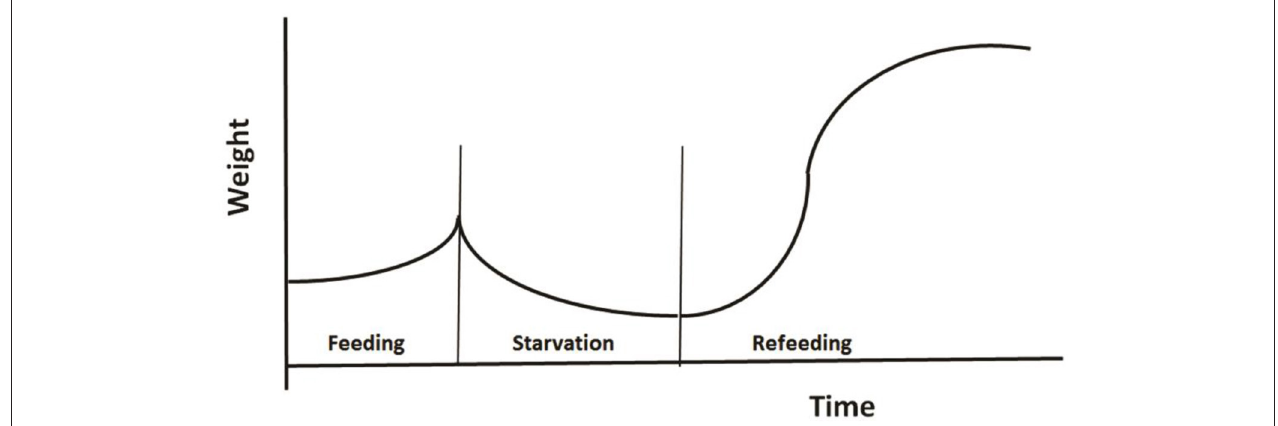
FIGURE 5 | A typical pattern of weight change during a feeding-starvation-refeeding cycle, showing gradually increases under normal feeding and declines following food deprivation, then regains and may even reach a higher weight after refeeding (Redrawn from Broekhuizen et al.,